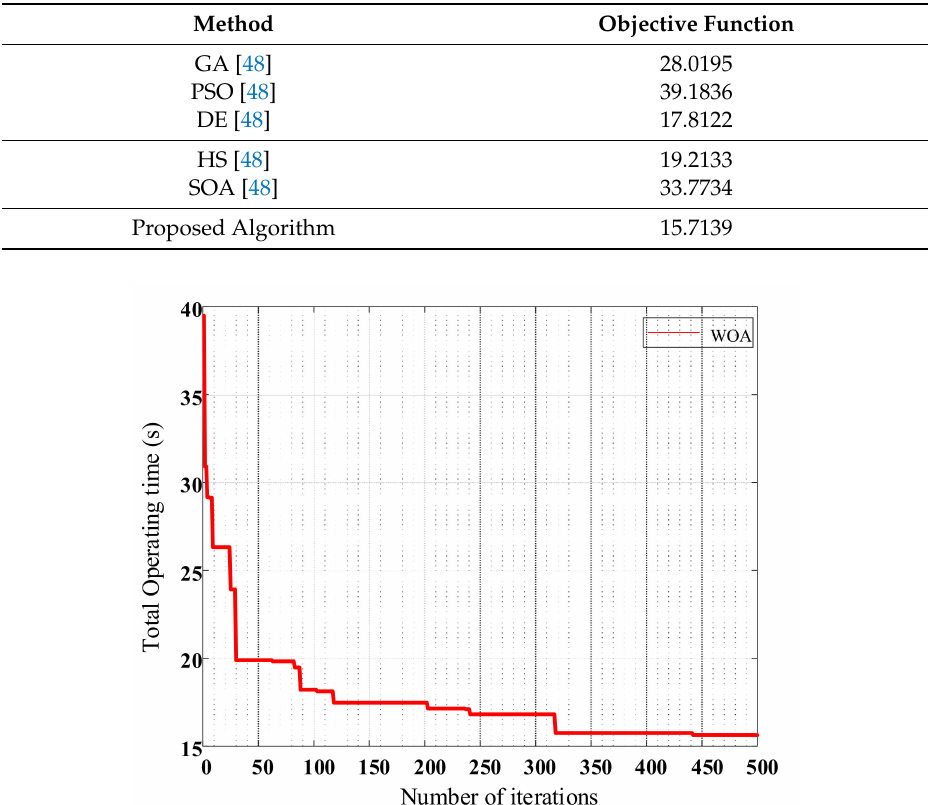
Table 18. Comparison of the proposed WOA with the methods used in the literature for the IEEE 30-bus system.